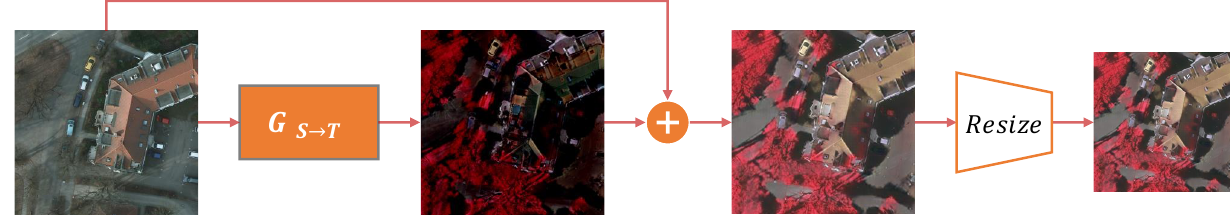
Figure 2. Resi-Generator of